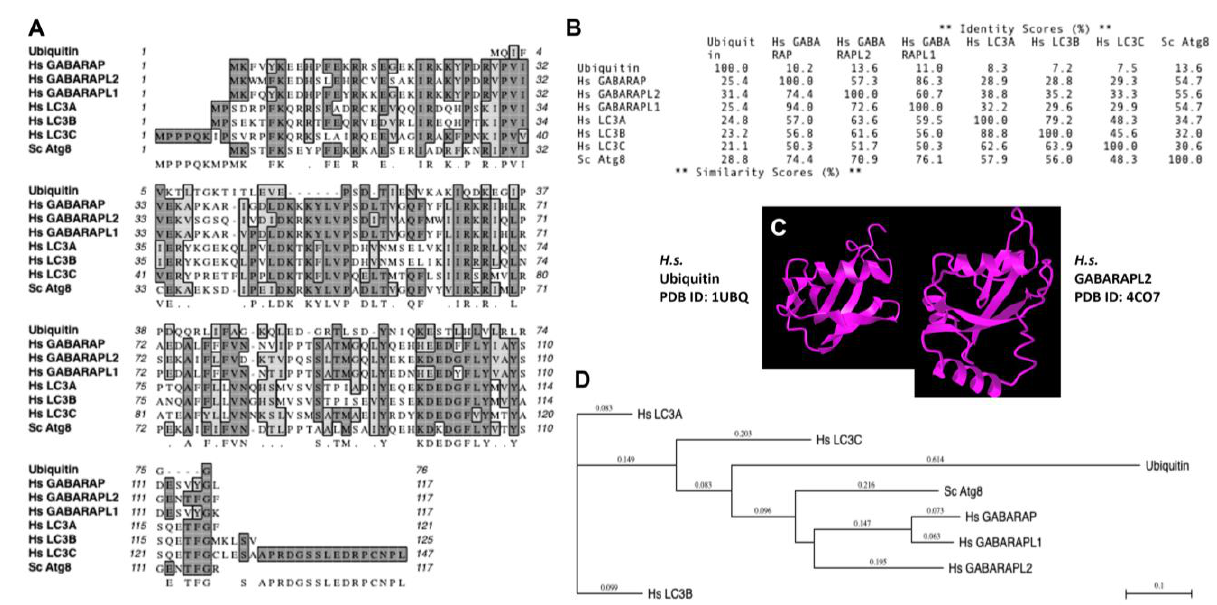
FIGURE 2: Similarities between ubiquitin and mAtg8s. (A) Multiple sequence alignment. (B) % similarities. (C) Crystal structure comparison between ubiquitin and GABARAPL2. (D) Evolutionary relatedness